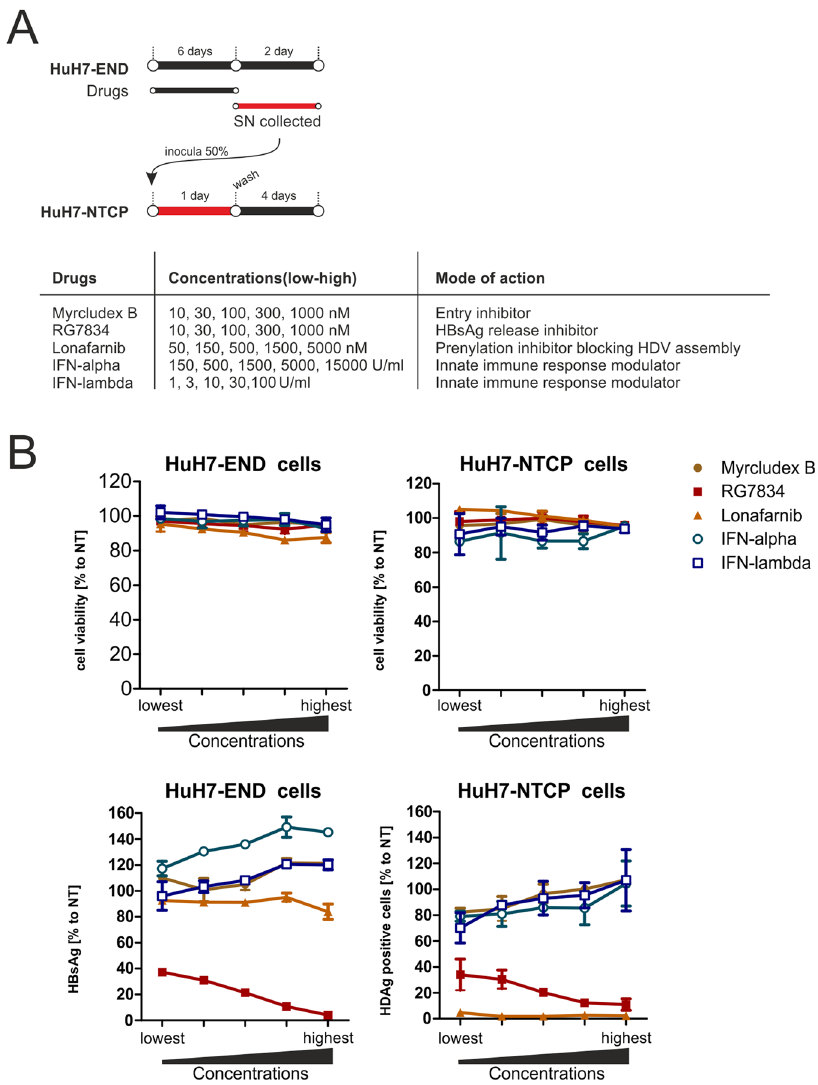
Figure 6. Evaluation of drug efficacy using HuH7-END cells. ( A ) Schematic presentation of a combined drug screening approach using HuH7-END cells in 96-well plate. 5 different substances (MyrB, RG7834, Lonafarnib, IFN-alpha and IFN-lambda) with different modes-of-action (right) were administered for 6 days in HuH7- END cells. Following removal of the drug, cells were cultivated for another 2 days and the culture supernatant was analyzed for HBsAg and used to infect HuH7-NTCP cells. ( B ) Cell viability tested by WST-1 assay (upper panels) and quantification of HBsAg secretion in HuH7-END (lower left) and infectivity assay determined in HuH7-NTCP cells (lower right). NT, non-treated